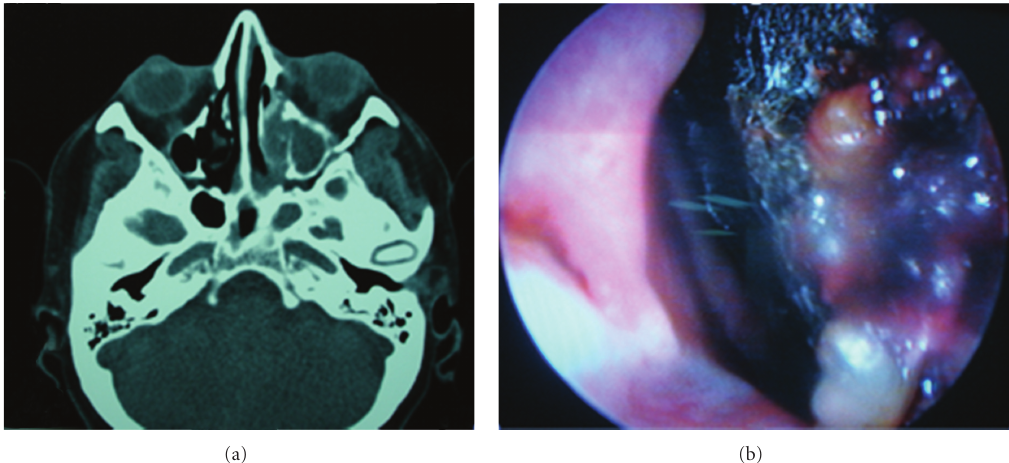
Figure 1: (a) CT scan of patient with invasion of left paranasal sinuses and orbit. (b) Necrotic sinus tissue found on endoscopy.